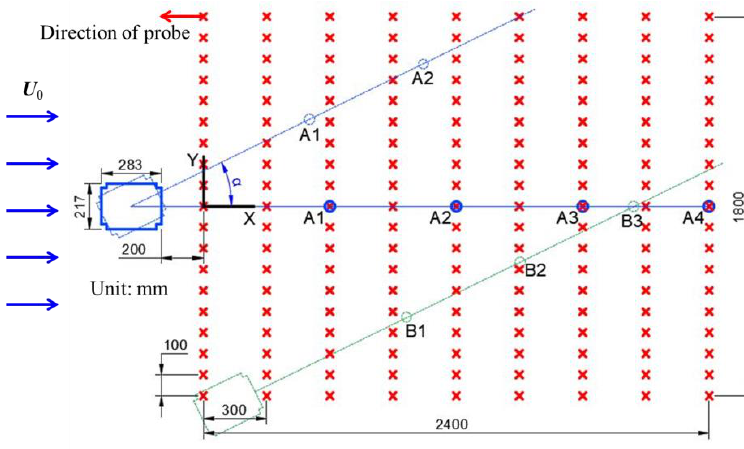
Figure 3. Measurement points arrangement sketch map.